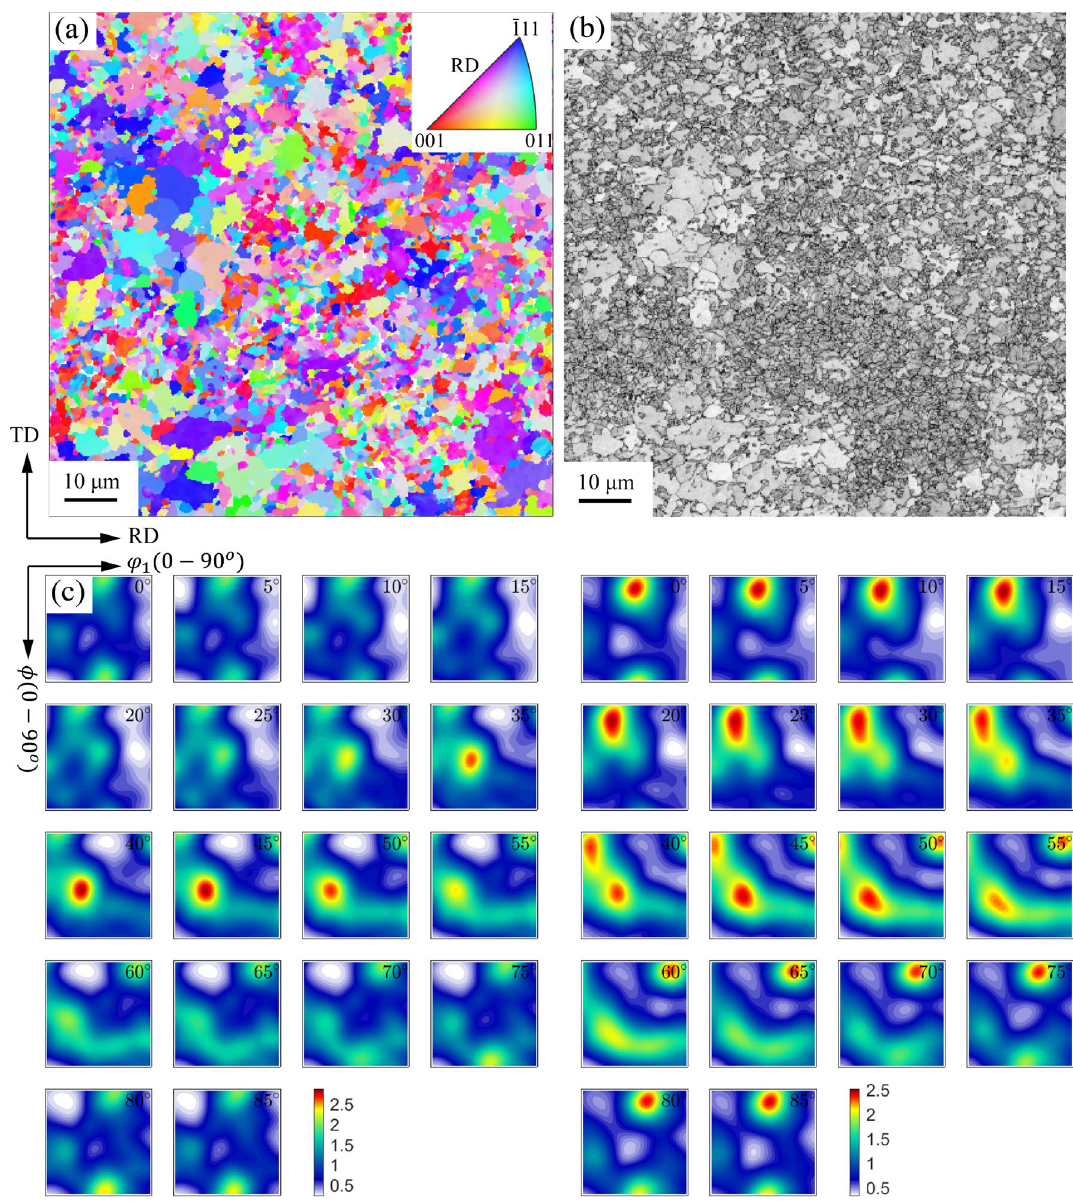
Figure 4. The initial microstructure of the as-received DP980 sheet characterized on the RD-TD plane at the center in thickness. ( a ) The EBSD orientation imaging map (OIM); ( b ) the band contrast map; ( c ) the orientation density function (ODF) maps reconstructed from the EBSD data of the ferrite and martensite o o o phases, respectively. The ODFs were sectioned (constant ϕ 2 sections, from 0 to 85 in 5 steps) through the reduced Euler space (with the Bunge convention) for the cubic-orthorhombic symmetry. This figure was generated by the MATLAB® (version R2018b) open-source toolbox MTEX 38 of 8 MPa, respectively. It can be seen from the results that the deviation among the yield functions increases with the ratio of shear stress, and the difference is noticeable in the case of σ 12 / ¯ σ > 0.5. In‑plane anisotropy of deformation and strength. For polycrystalline metal sheets, the variations of r -value and normalized yield stress ( Y θ ) with uniaxial tensile directions are commonly employed to measure the in-plane anisotropy of deformation and strength. Figure 8 presents the comparisons of the r -values predicted by the calibrated yield functions and obtained from the experiments and the virtual tests of uniaxial tension. Fig- ure 8a and b correspond to the results at deformation stages with the specific plastic work of 3 MPa and 8 MPa, respectively. Figure 9 presents the normalized yield stresses. Note that the experimental results at the specific plastic work of 60 MPa were also provided for checking the variation of r -values with deformation. As shown in Fig. 8, the r -values obtained from the experiments are fairly consistent with those predicted by the virtual tests and by the calibrated yield functions. The DP980 sheet exhibits the typical deformation anisotropy